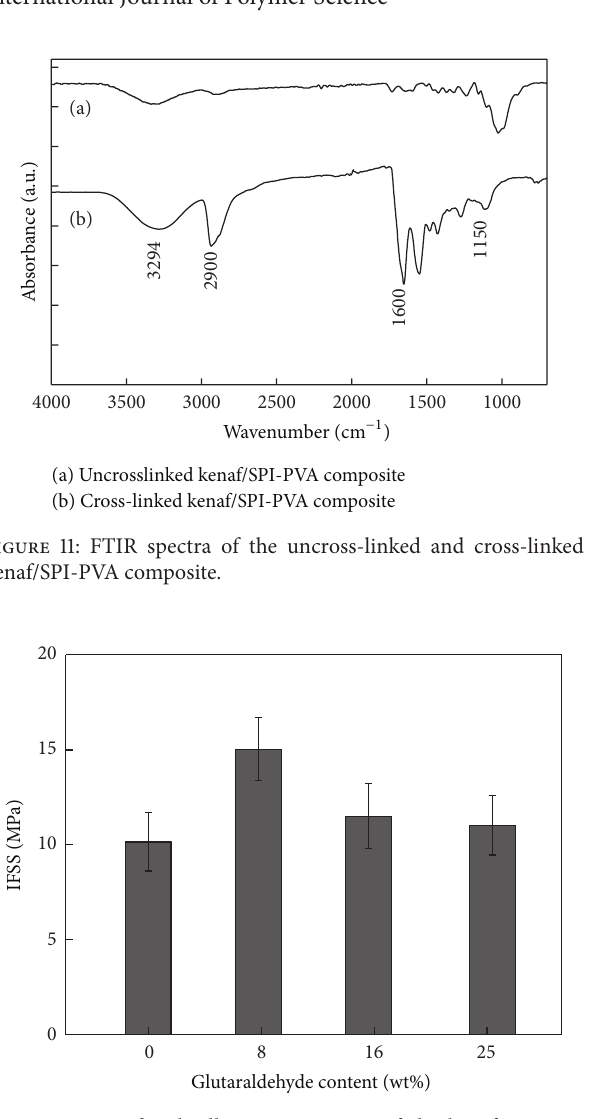
Figure 12: Interfacial adhesion properties of the kenaf/SPI-PVA composites with GA content.